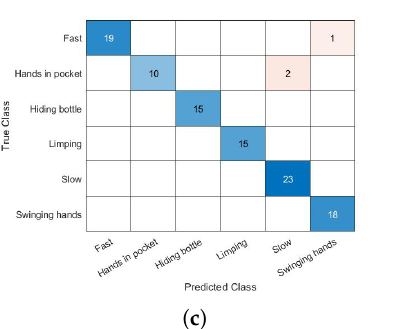
Figure 16. Confusion matrix for six different walking patterns. ( a ) Confusion matrix for micro- Doppler signatures; ( b ) confusion matrix for interferometric signatures; ( c ) confusion matrix for dual micro-motion